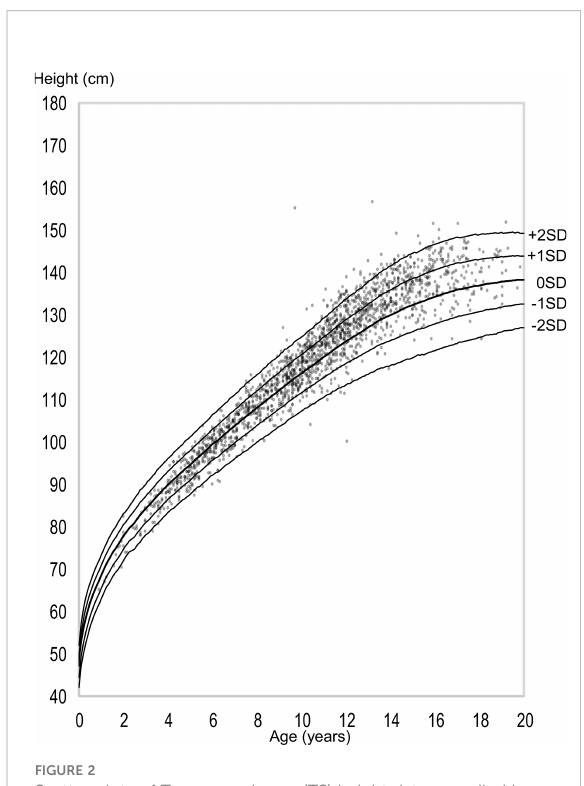
FIGURE 2 Scatter plots of Turner syndrome (TS) height data compiled by the Foundation of Growth Science, Japan, on the previous TS growth charts